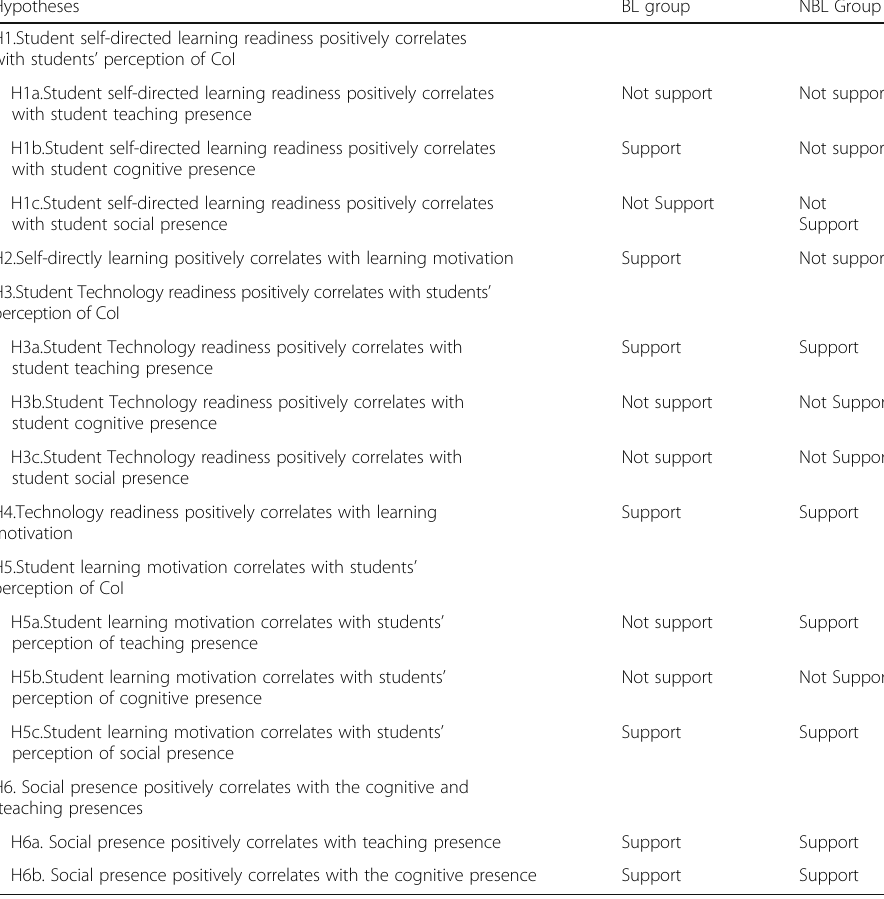
Table 9 Hypotheses testing